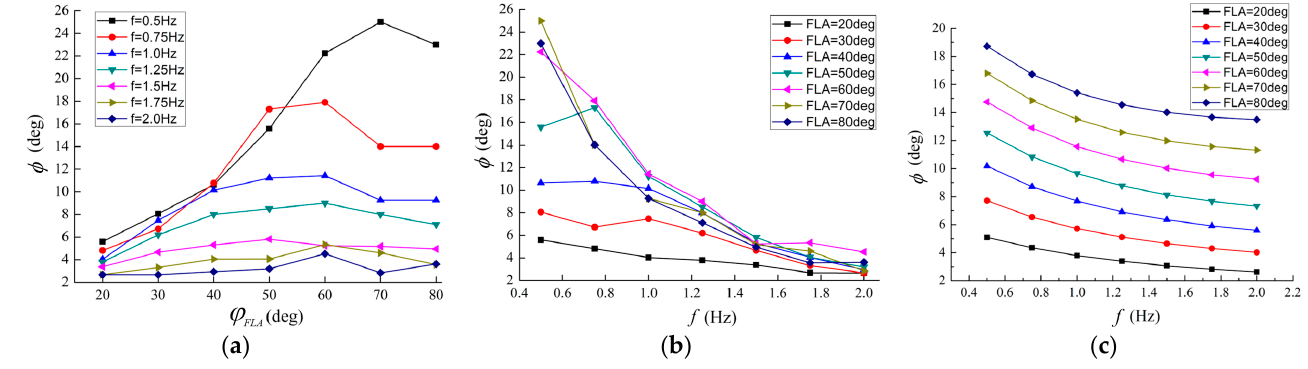
Figure 15. The experiment results of swimming gait 2. ( a ) is the result of experiment for ϕ FLA . ( b ) is the result of experiment for f . ( c ) is the result of simulation. Table 3. Comparison of swimming speed between two gaits. ( f = 1.0 Hz).